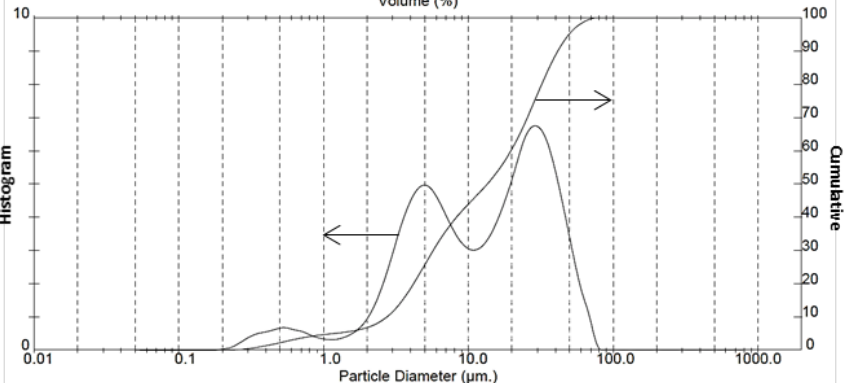
Figure 4. Particle size distribution of fully carbonated olivine, determined by